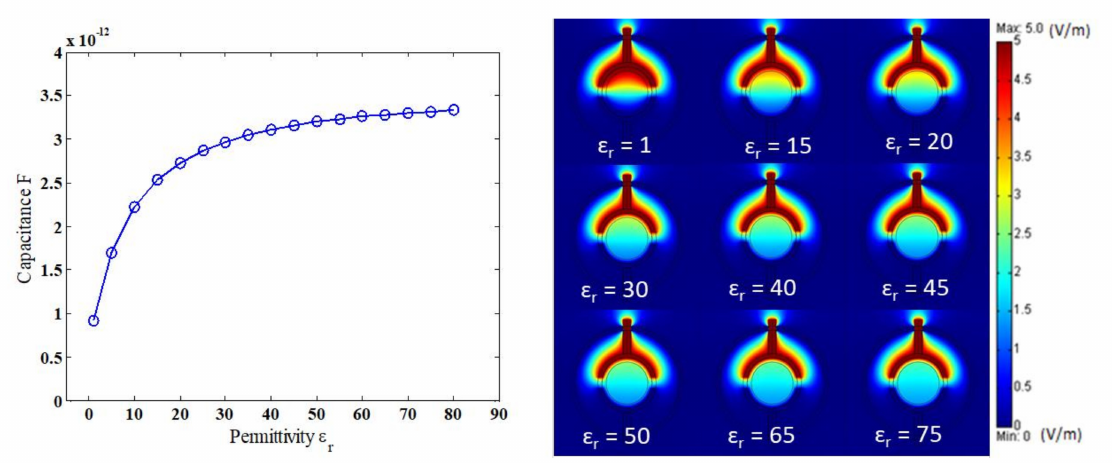
Figure 5. The e ff ect of the permittivity on the simulated sensor capacitance value ( ε r = 1 for gas phase only and ε r = 80 for the liquid phase